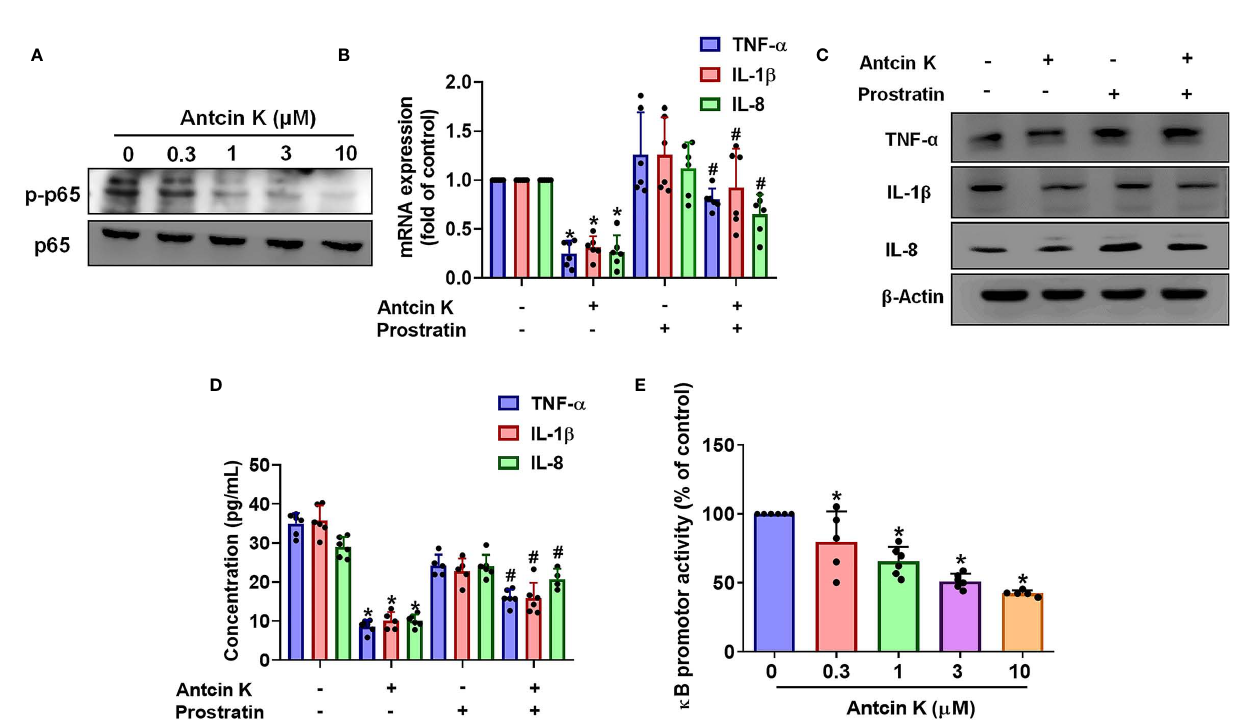
FIGURE 6 | The NF- k B pathway is involved in Antcin K-induced inhibition of TNF- a , IL-1 b and IL-8 production in RASFs. (A) Cells were treated with Antcin K (0.3, 1, 3 or 10 m M) for 24 h and NF- k B phosphorylation was examined by Western blot. Cells were pretreated with the NF- k B activator (prostratin) for 30 min, then treated with Antcin K (10 m M) for 24 h. (B – D) TNF- a , IL-1 b and IL-8 mRNA expression and protein secretion were examined by qPCR, Western blot and ELISA. (E) Cells were transfected with the NF- k B luciferase plasmid, then incubated with Antcin K (0.3, 1, 3, or 10 m M) for 24 h and luciferase activity was determined. Results are expressed as the mean ± SD. * P < 0.05 compared with controls; # P < 0.05 compared with the Antcin K-treated